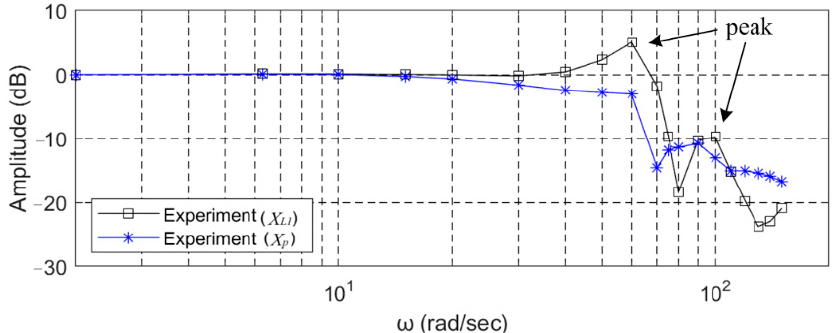
Figure 14. The dynamics of an uncompensated electro-hydraulic actuator and its engine load. It is worth noting that, without compensations, with a relatively small open loop gain, the system vibrates seriously, as shown by the amplitude peaks of the load response X L 1 in Figure 14. It is clear that the system has to be compensated for a bigger gain and hence better dynamics.